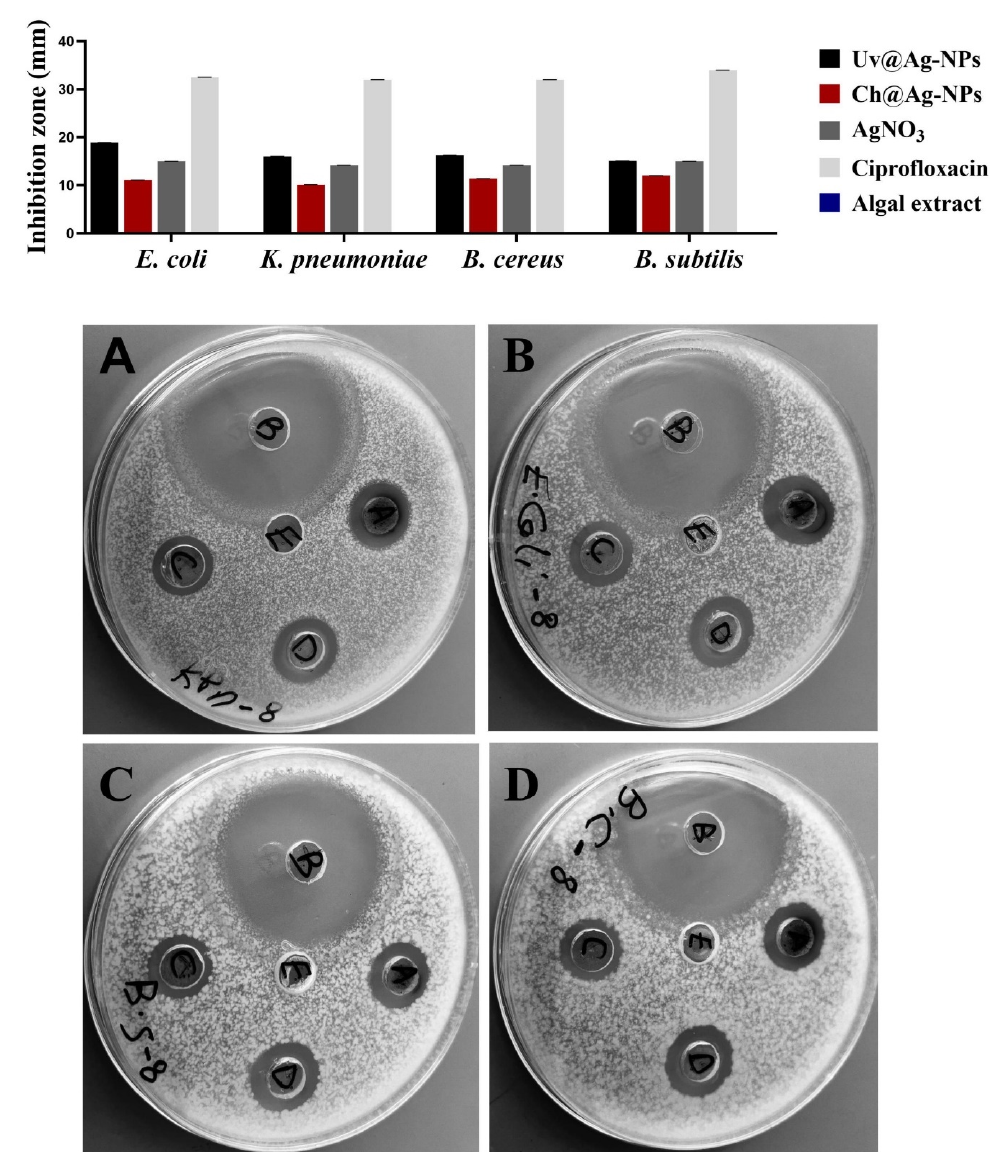
Figure 12. Inhibitory activities of 1 mg/mL of Uv@Ag-NPs, Ch@Ag-NPs, AgNO 3 , algal extract, and ciprofloxacin against E. coli , K. pneumoniae , B. cereus , and B. subtilis . Letters written on well refer to